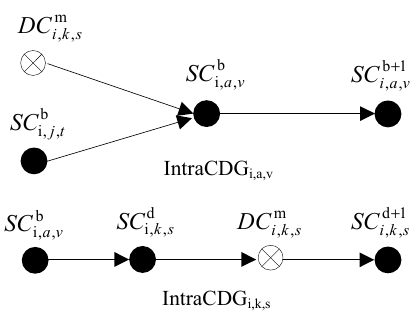
Figure 7. IntraCDG i,a,v and IntraCDG i,k,s .